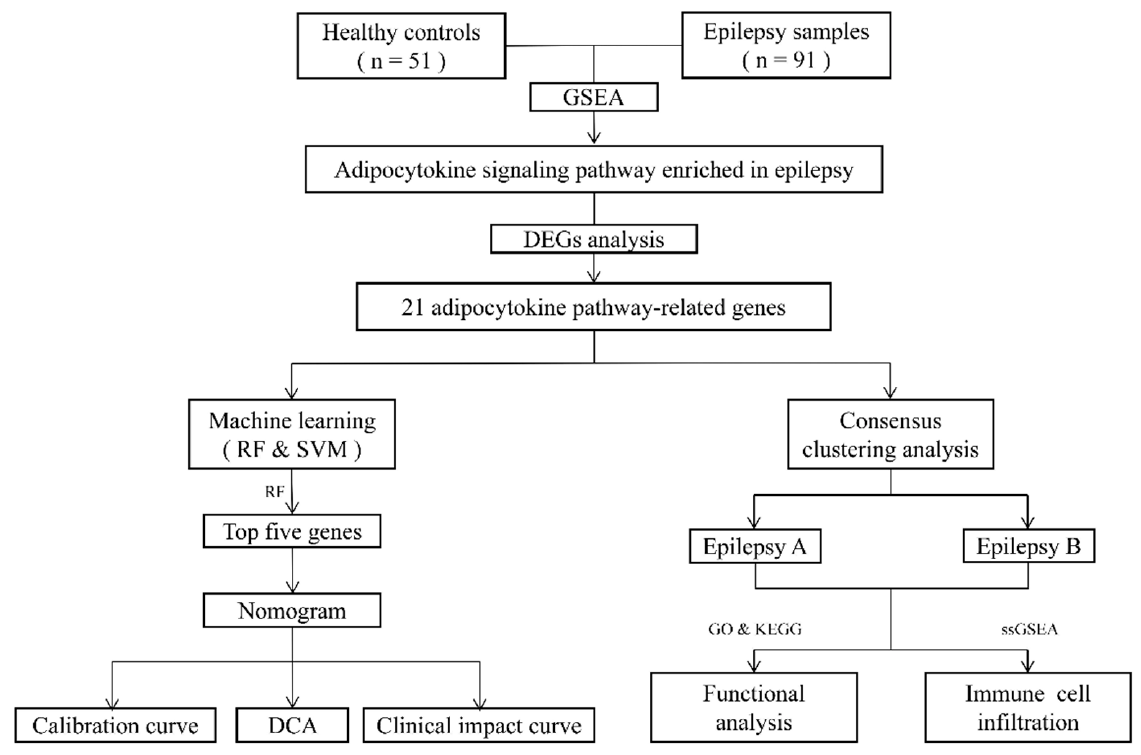
Figure 1. The flowchart of this study.